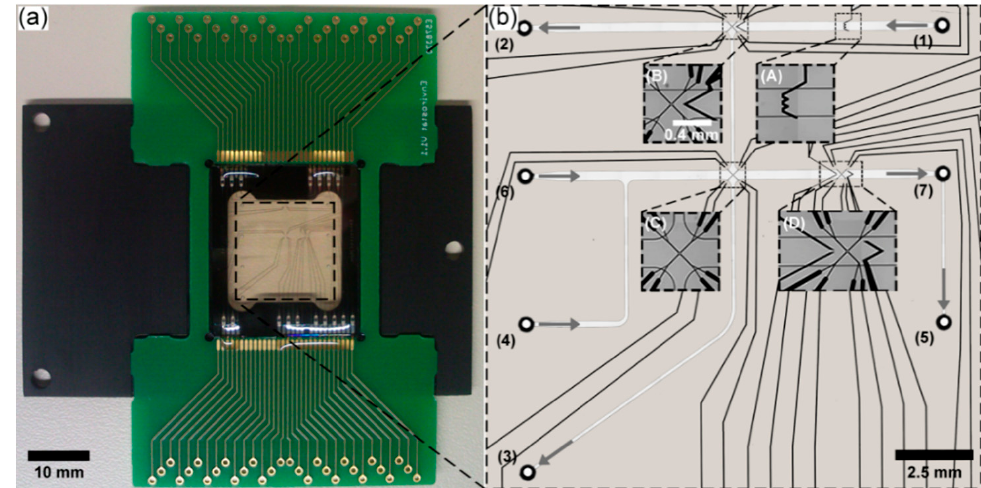
Figure 2. The Envirostat system: ( a ) The microfluidic chip is directly bonded and mounted on an aluminum plate and wire-bonded to a PCB-board; ( b ) microscopic magnification of the chip with microfluidic channels, microelectrodes and in-/outlets. (1) Inlet for cell suspension. (2) Outlet for waste cells. (3) Outlet for waste. (4) Inlet for cultivation medium supply. (5) Outlet for cultivation medium and sampling. (6) Inlet for cultivation medium change. (7) Outlet for cell deposition. (A) Cell retaining unit, (B) cell separation unit, (C) cell isolation unit, (D) cell analysis unit.